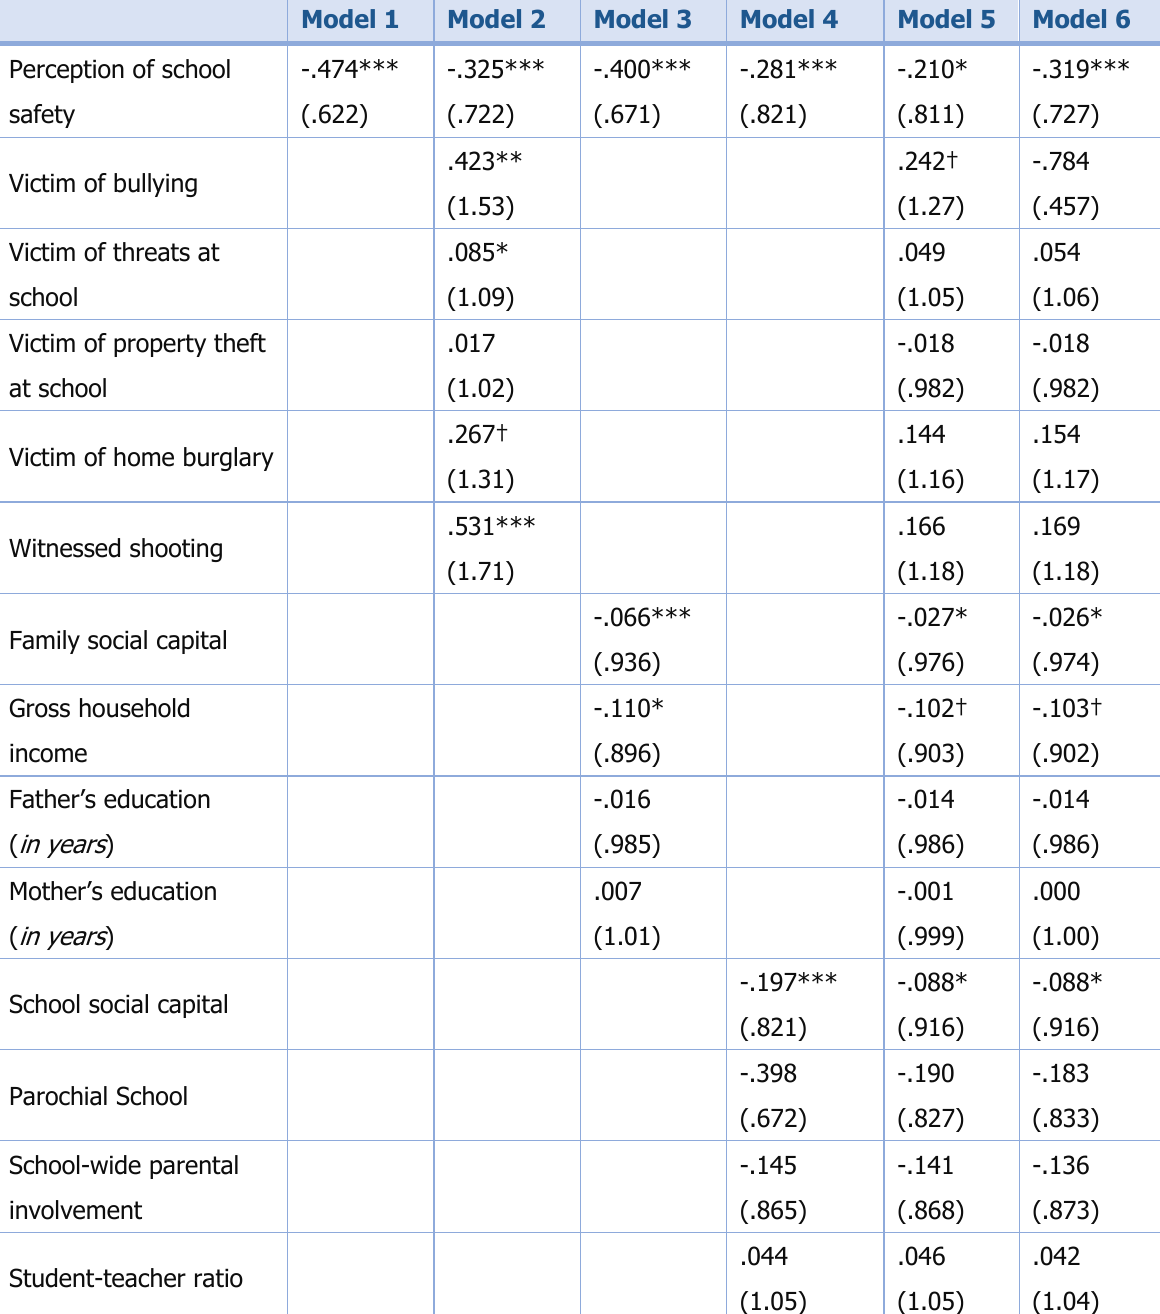
Table 2. Summary of Logistic Regression Analyses Predicting Likelihood of Running Away From Home (N =